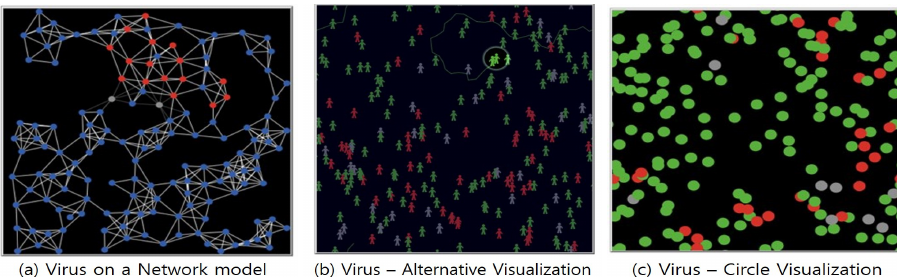
Figure 2. Examples of disease models using ABM [23]: ( a ) spread of viruses on computer networks; ( b , c ) this model visualized the spread of disease in human